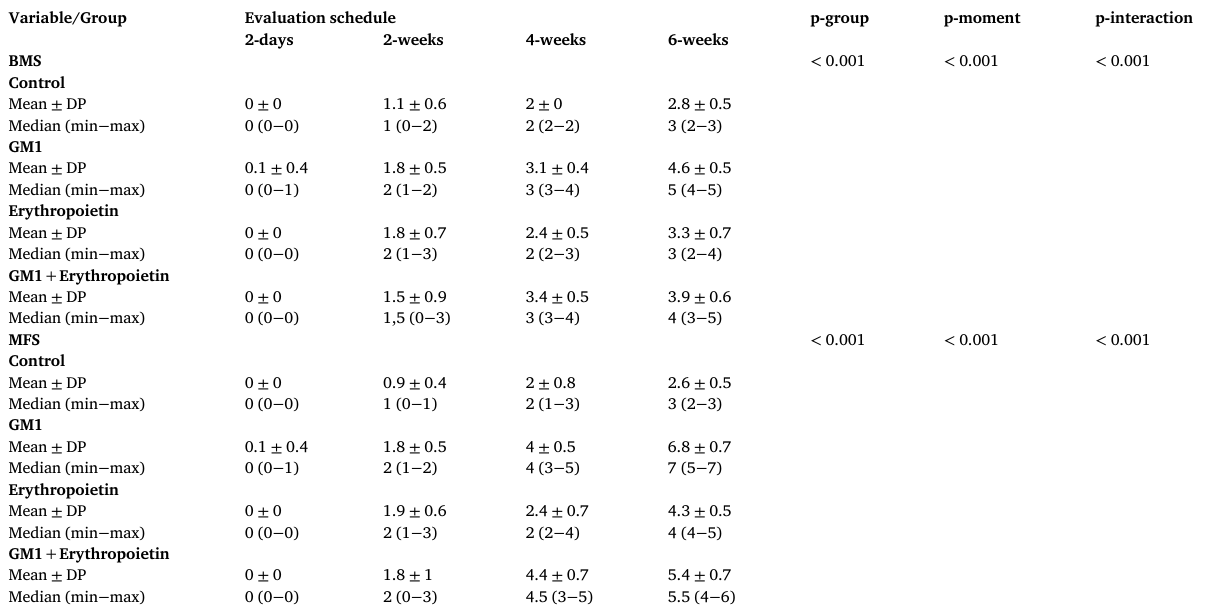
Table 2 Description of functional scales per group and assessment time point after injury induction and results of comparative tests. Variable/Group